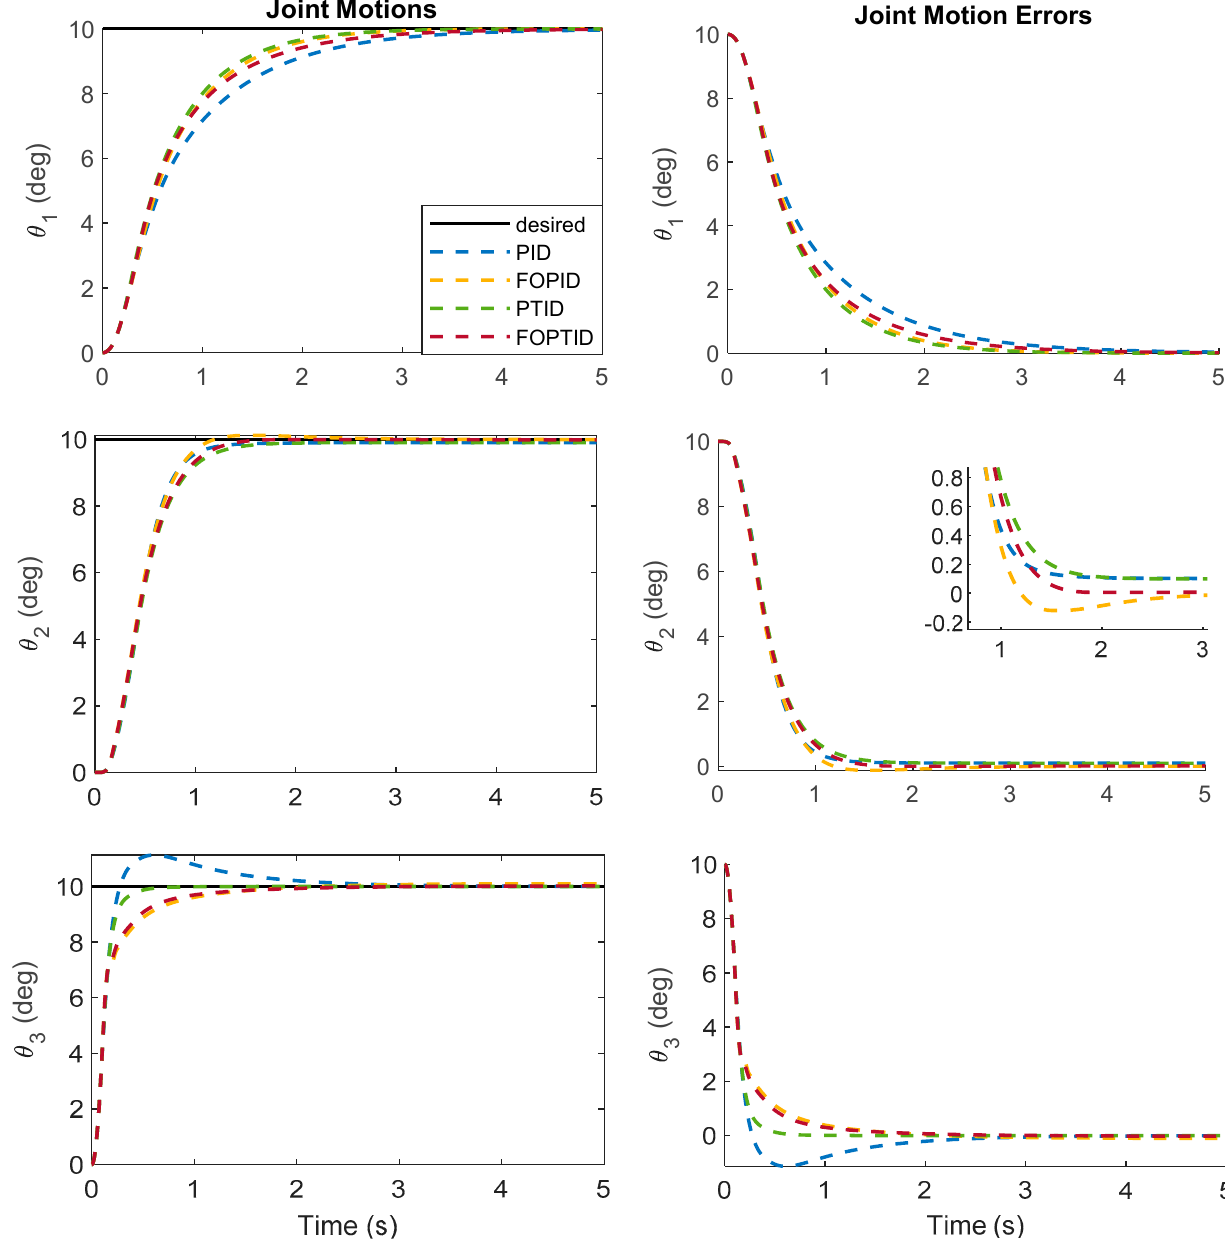
Figure 15. Joint tracking profiles and corresponding error profiles with respect to the presented controllers under friction. Table 2. Coulomb plus viscous friction model parameters.